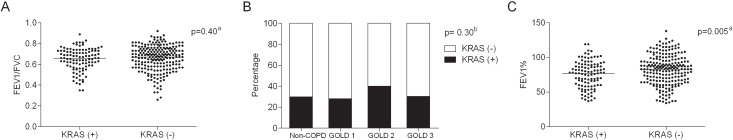
KRAS mutations and severity of airflow obstruction.(A) FEV1/FVC, (B) COPD GOLD classification and (C) FEV1 percentage in KRAS mutant and wildtype patients with NSCLC. aP-value was calculated by student t-test. bP-value was calculated by Chi-square test.